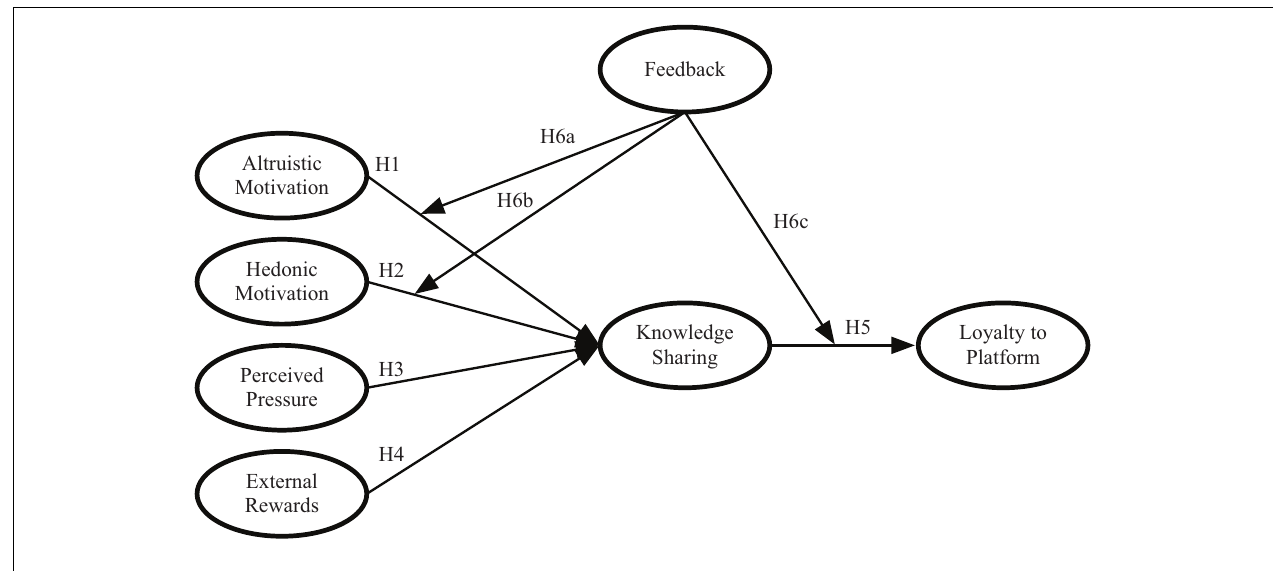
FIGURE 1 | Hypothesized